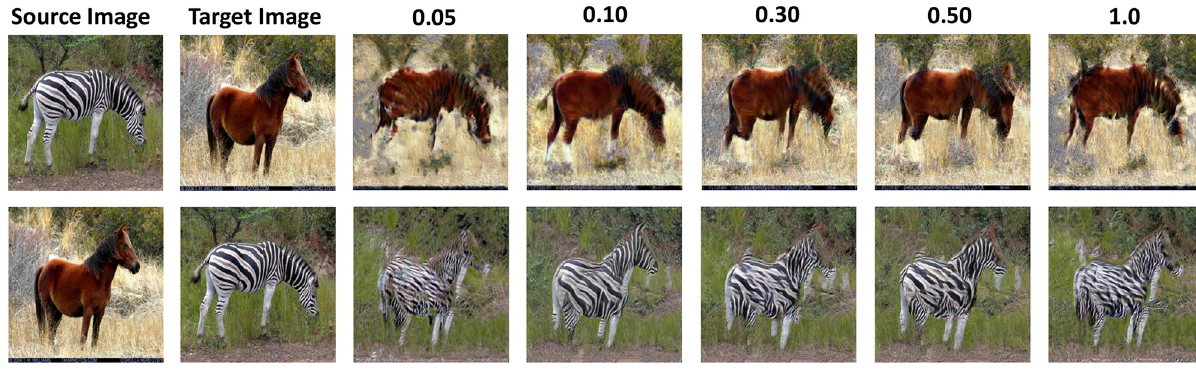
Fig 10. Visual results of scale factor η .